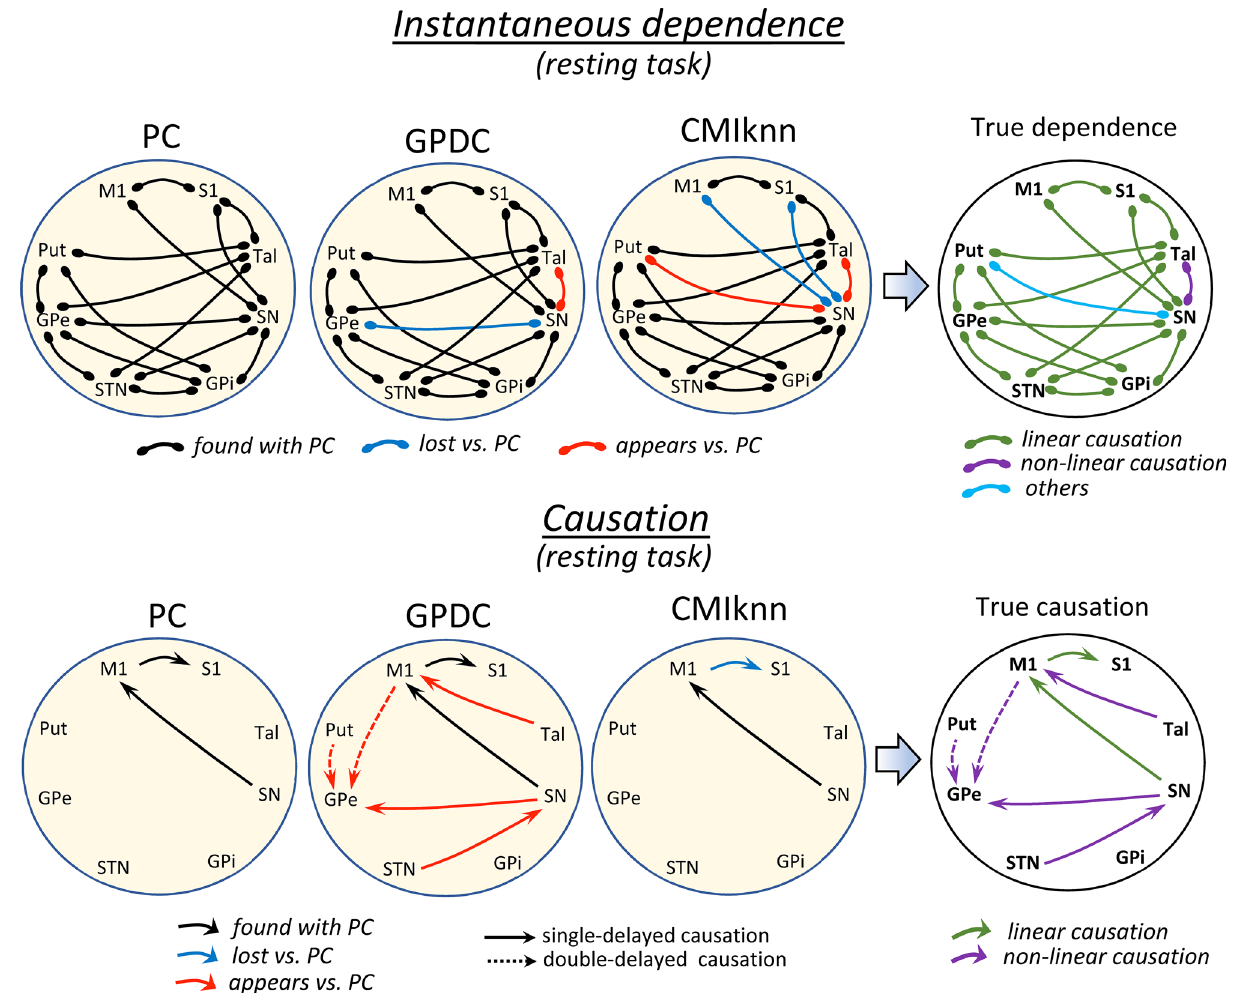
Figure 1. Instantaneous dependence vs. delayed causation during the resting task. Connections between centers show dependence or causation relationships with statistical value ( p < 0.01). A summary of the main dependence relationships is shown at the top-right (true dependence), and a summary of the main causation relationships is shown at the bottom -right (true causation). PC: partial correlation, GPDC: Gaussian process regression and distance correlation, CMIknn: conditional mutual information test (based on nearest-neighbor). M1: primary motor cortex, S1: primary somato-sensory cortex, Put: putamen, GPe: external globus pallidum, STN: subthalamic nucleus, GPi: internal globus pallidum, SN: substantia nigra, Tal: motor